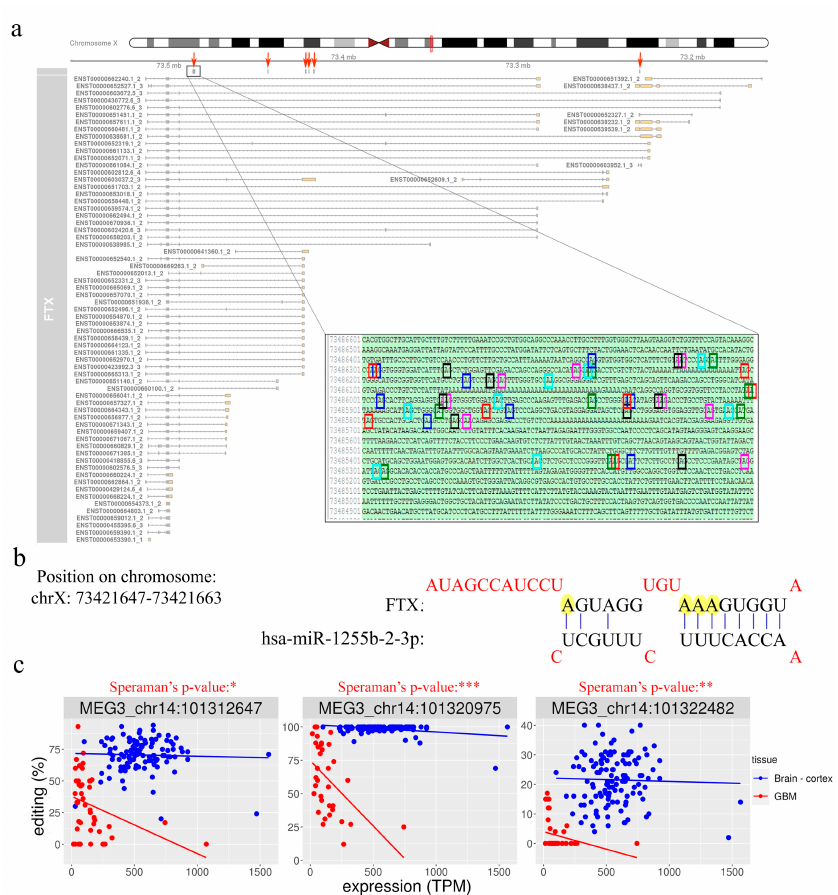
Figure 5. FTX long non-coding RNA is hyper-edited but downregulated in GBM. ( a ) Overview of FTX transcript structures as reported in the GENCODE / Ensembl annotation, with six red arrows indicating the clusters of editing sites that are significantly deregulated in GBM compared to normal brain cortex. In the box, an enlarged view of one of the edited adenosine clusters is shown at sequence level. ( b ) MicroRNA binding prediction on FTX transcript showing that some edited adenosines may potentially a ff ect the miRNA–lncRNA interaction. ( c ) Correlation plots between MEG3 editing levels (%) and gene expression (TPM) for three sites di ff erentially edited among GBM and normal cerebral cortex. Scatter plots and regression lines are reported in blue for normal brain samples and in red for GBMs. For each site, the Spearman’s correlation p -value calculated in GBM is also reported. * p ≤ 0.05, ** p ≤ 0.01, *** p ≤